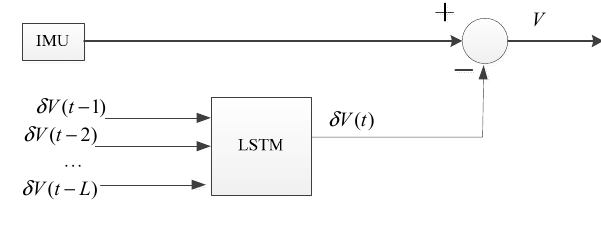
Figure 7. Prediction process.